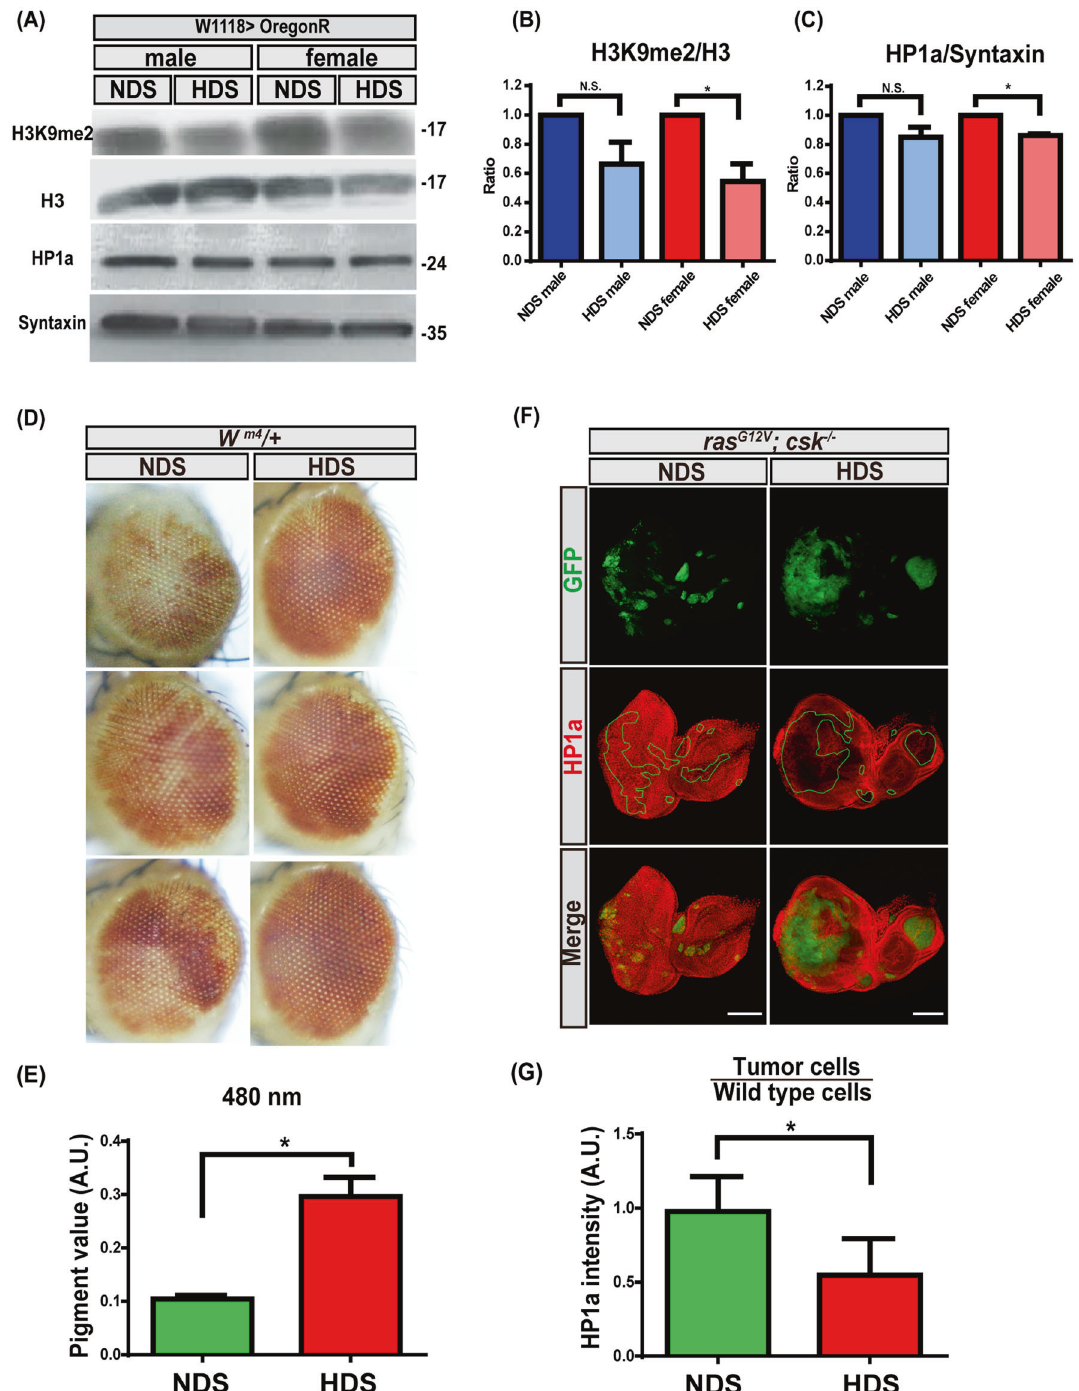
Fig. 2 HDS decreases heterochromatin formation. A Western blots of protein from the heads of wild type adult fl ies fed NDS or HDS, using antibodies against H3K9me2, H3, HP1a, or Syntaxin (loading control). B , C Quanti fi cation of B H3K9me2 and C HP1a levels from western blots in A , normalized to H3 and Syntaxin, respectively. All results analyzed and presented re fl ect data from three independent experiments ( n = 90). D Eyes from adult w m4 outcrossed wild-type w 1118 fl ies fed NDS or HDS for assessment via the PEV assay. E Pigmentation data from the eyes pictured in D , after pigment was extracted and measured at 480 nm. All results analyzed and presented re fl ect data from three independent experiments ( n = 30). F Third instar eye discs of ras G12V ; csk − / − tumor-bearing fl ies fed NDS or HDS, with GFP-labeled tumor cells (green) and HP1a immunostaining (red). Scale bar: 100 μ m. G Immuno fl uorescence intensity of HP1a in tumor cells from fl ies fed HDS compared to those of tumor cells from fl ies fed NDS. Staining intensity was normalized to that of non-tumor cells in each experimental condition. All results analyzed and presented re fl ect data from three independent experiments ( n = 15). Results are shown as mean ± SD. Asterisk indicates statistically signi fi cant difference (* p < 0.05). GFP green fl uorescent protein, HDS high dietary sugar, NDS normal dietary sugar, NS not signi fi